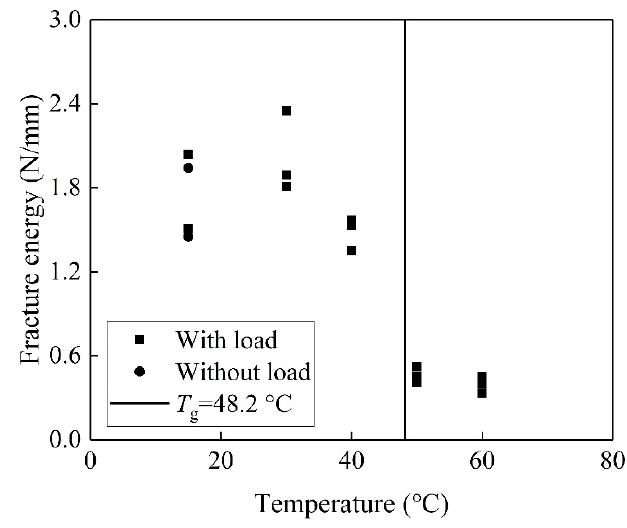
Figure 5. Interfacial fracture energy vs. temperature at the surface of BFRP.